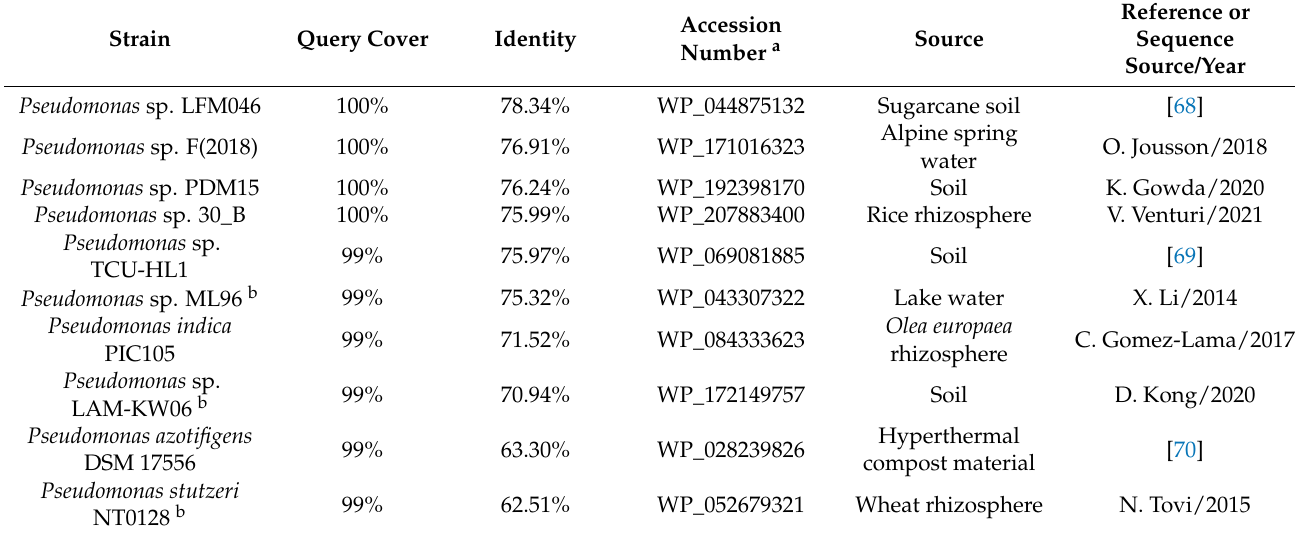
Table 5. Protein homologs to CmpA from Pseudomonas alcaligenes AVO110 in other bacteria. Strain